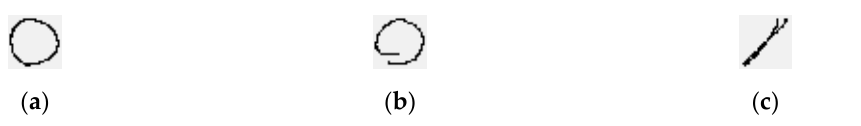
Figure 7. The images resulting from data normalization and 3D mapping. ( a – c ) Are the mappings of X-Y, X-Z, and Y-Z planes respectively. Because the “circle” gesture is 3D, the images in the X-Z and Y-Z planes may not look like circles.